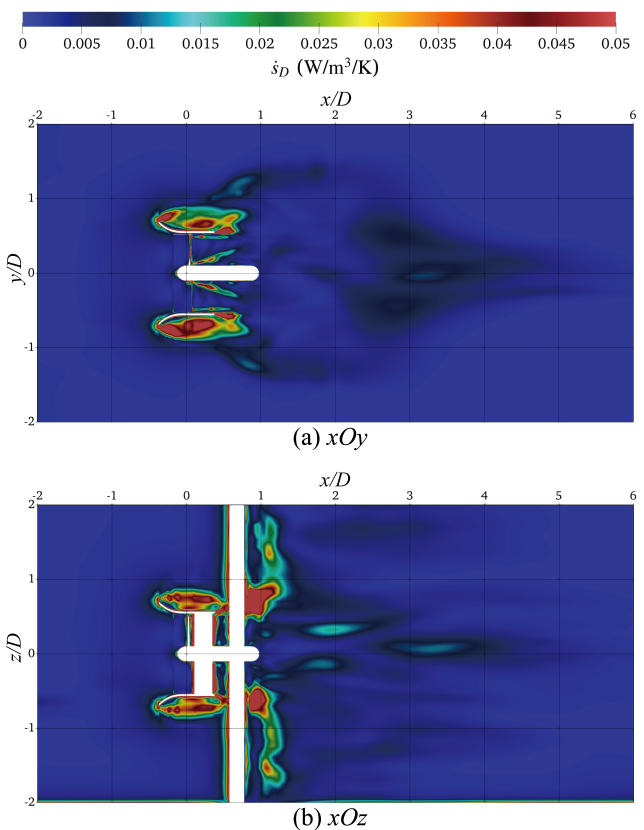
Figure 8. Contours of entropy production rate (˙ s D ) on horizontal and vertical plane ( TSR = 3.6 )